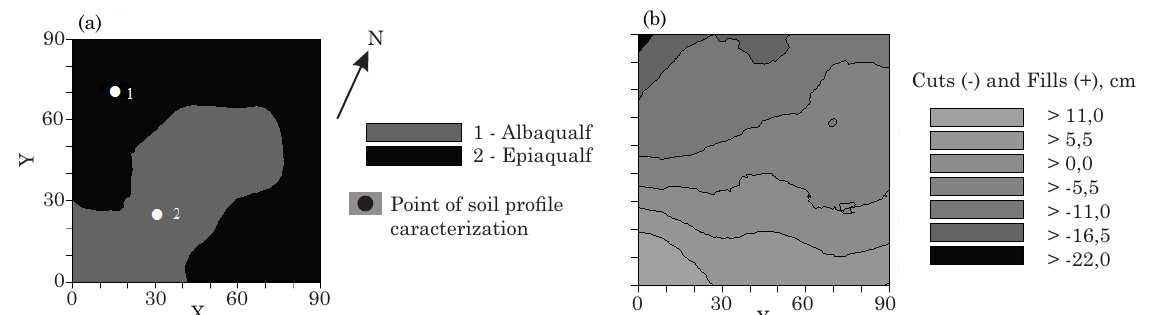
Figure 1. (a) Soil spatial distribution in the experimental area: (1) “Gleissolic Planossolo háplico eutrófico” (Typic Albaqualf) in the relatively high portion, and (2) “Solodic Gleissolo háplico Ta eutrófico” (Umbric Epiaqualf) in the lower portion. (b) Map of cut and fill